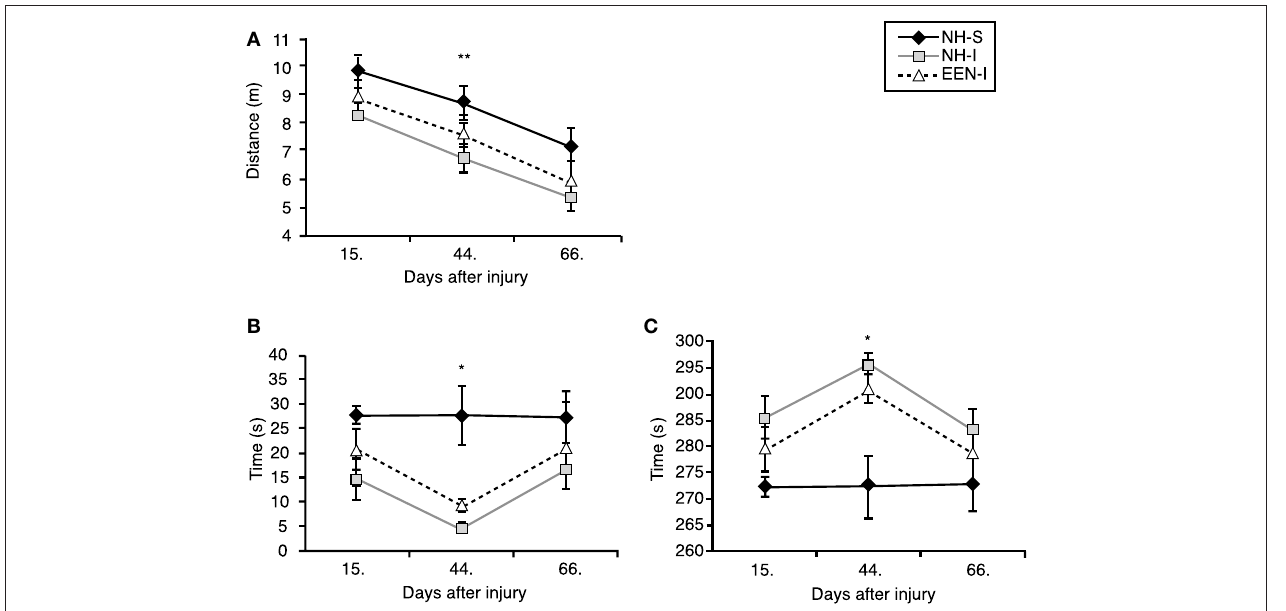
arms (C) were measured at 15, 44, and 66 days after mbTBI. Housing rats in EEN after mbTBI mildly improved motor function and reduced anxiety. * p < 0.05 and